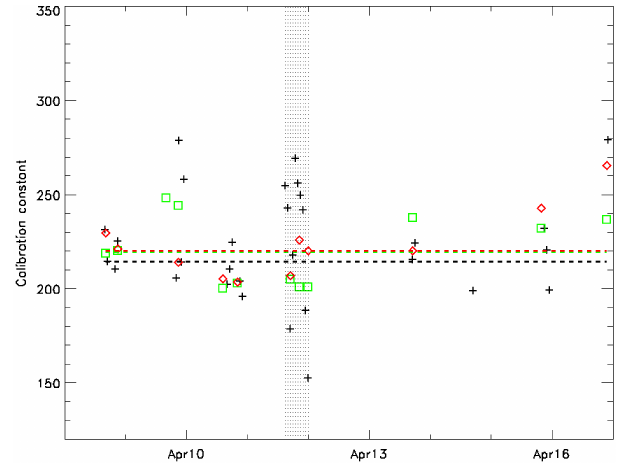
Figure 9. Time series of IWV estimated by GPS, RS92 and RMR- H 2 O lidar calibrated through the GPS procedure (black crosses, red diamonds and blue stars, respectively) for the period 8–16 April. Dotted vertical lines highlight the period between 15:00UTC of the 11 April and the 00:00UT of 12 April